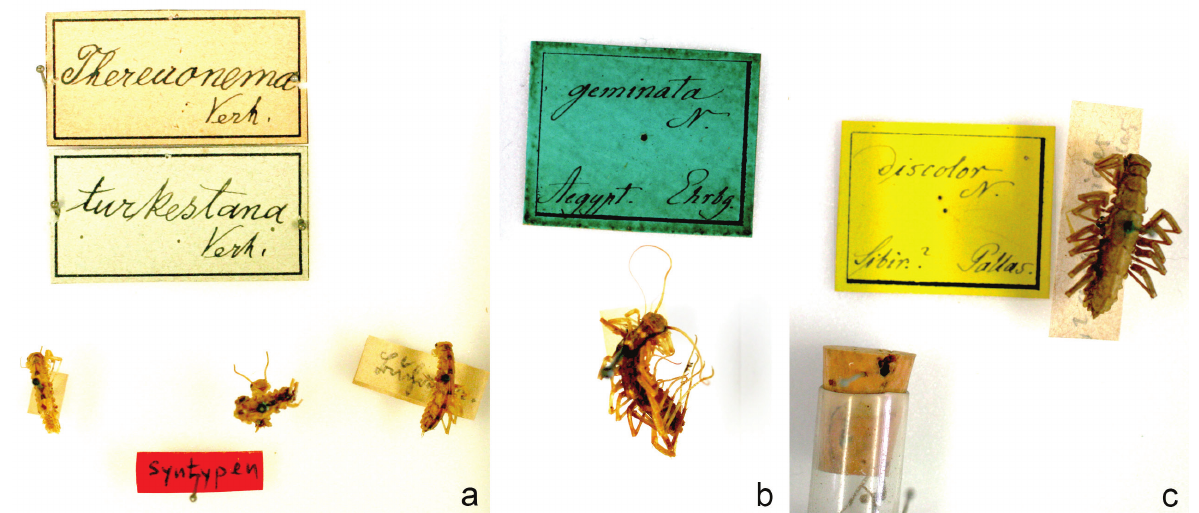
Figure 3. Historical dry, pinned specimens of scutigeromorph centipedes. a. ZMB 87, syntypes of Thereuonema turkestana Ver- hoeff, 1905 collected by Eduard Friedrich Eversmann in Bukhara in 1820. b. ZMB 88, Scutigera sp. collected by Christian Gottfried Ehrenberg in Egypt ca. 1820–1825. c. ZMB 89, Scutigera sp. apparently collected by Peter Simon Pallas possibly in Siberia ca. 1768–1774. Note that the specimens in b and c bear what appear to be (unpublished) manuscript names on the original